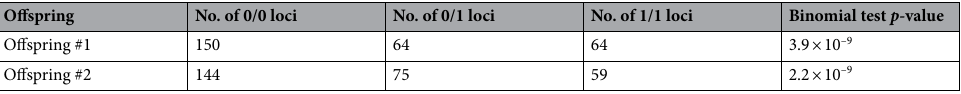
Table 2. A tally of the fate of maternal heterozygous loci (N = 278) in both offspring. 0/0, 0/1, and 1/1 encode homozygous and heterozygous locus genotypes based on the reference genome (0) and alternative alleles (1). The Binomial Test p -value column represents the results of two-sided binomial tests for each offspring that compared the proportions of 0/0 vs. 1/1 genotypes under the assumption of an expected proportion of 0.5 for each with random inheritance of unlinked